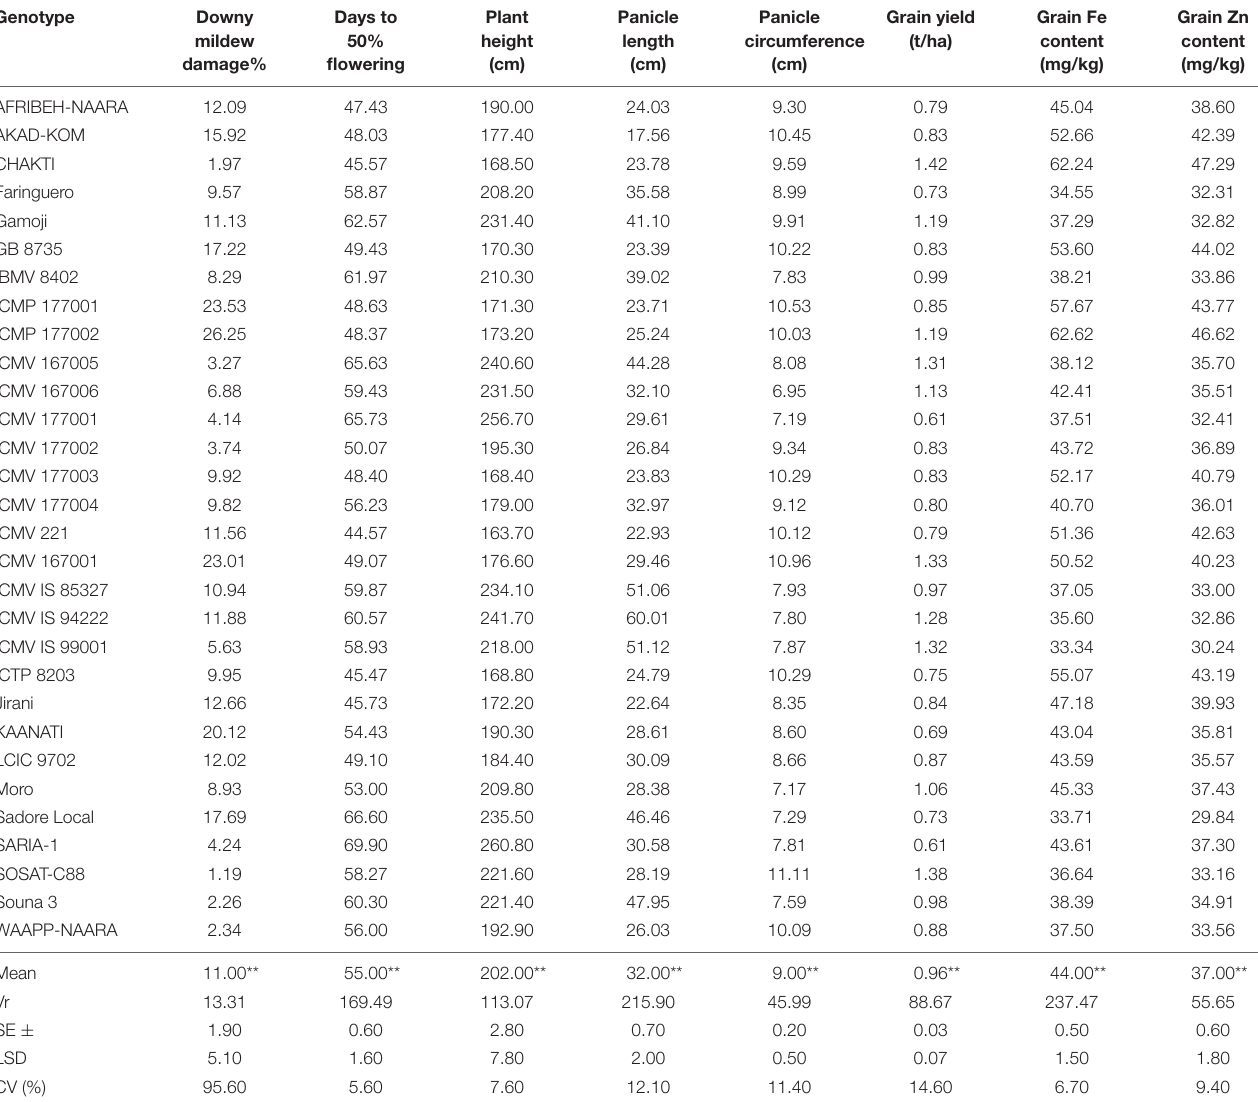
TABLE 2 | Mean performance of the pearl millet ( Pennisetum glaucum L.) genotypes across locations in West Africa.